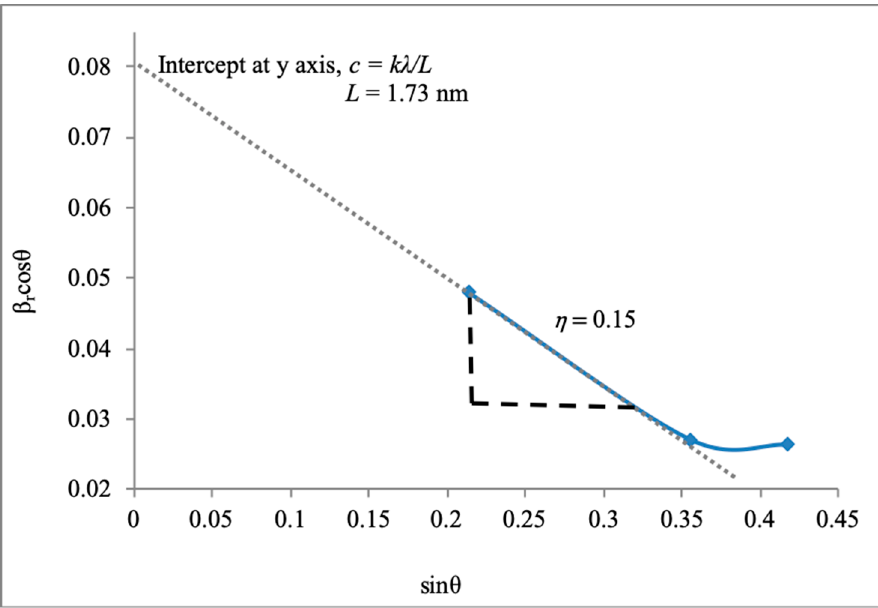
Figure 5. Plot of β r cos θ versus sin θ from XRD data of the 0.2 min sample.